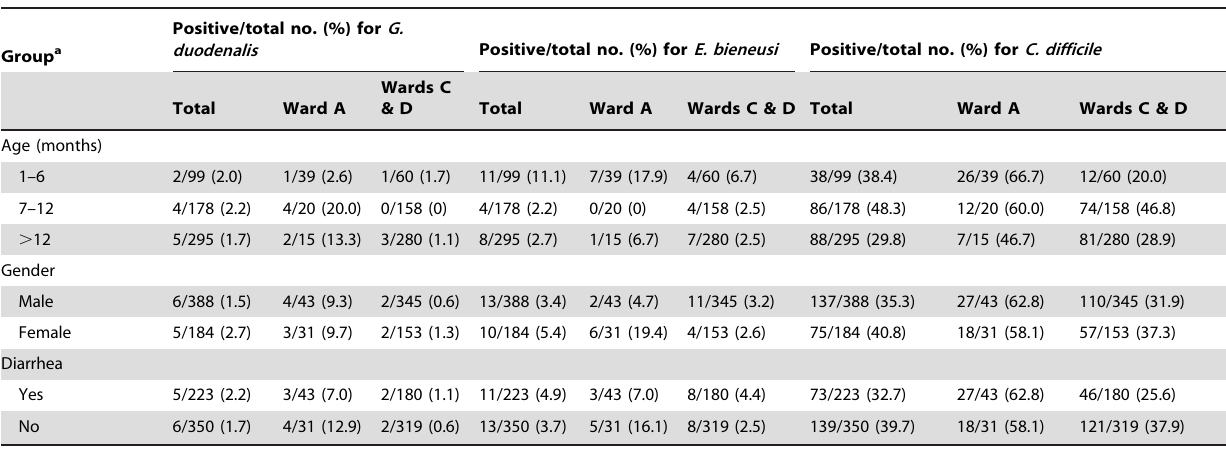
Table 2. Distribution of study pathogen infections in case (A) and control (C and D) wards by age, gender, and diarrhea status.